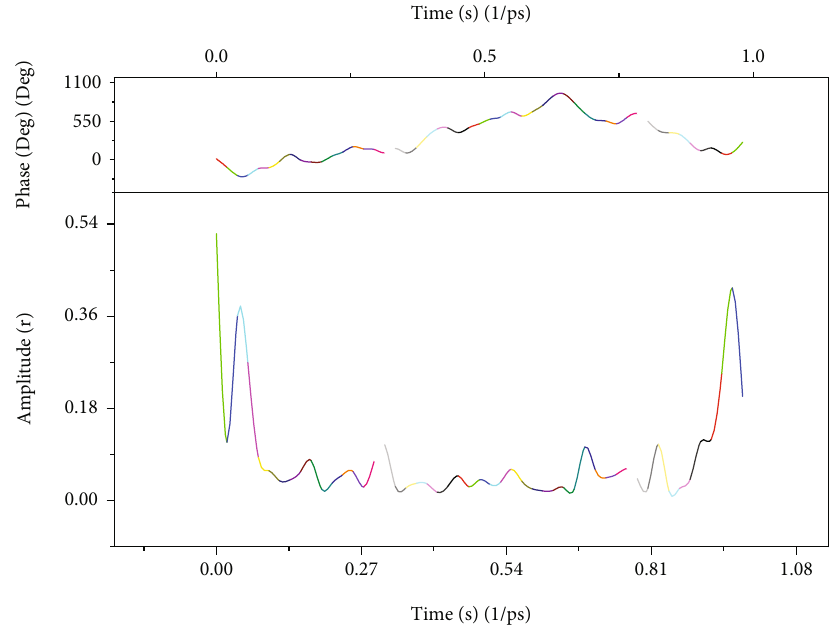
Figure 5: Signal input.